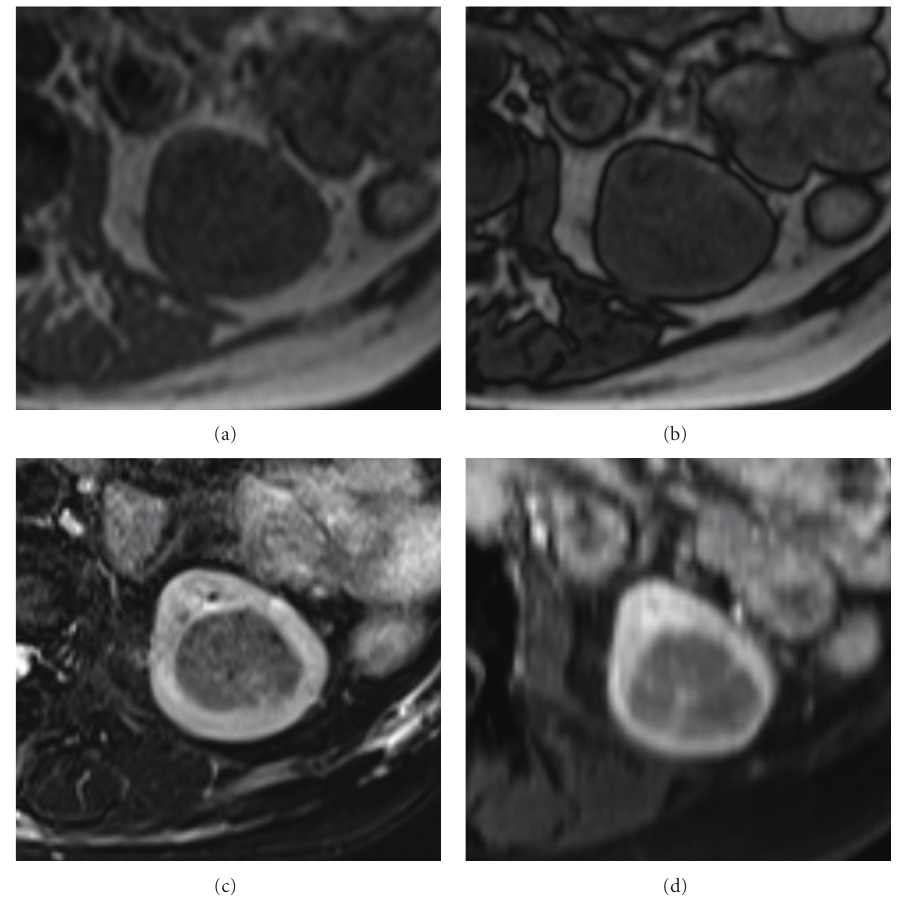
Figure 1: (a–d) Axial MR images of the left kidney, T1-weighted in-phase (a) T1-weighted opposed phase (b) T2-weighted fat-saturated (c), and T1-weighted, contrast-enhanced fat-saturated (d). The left renal mass is isointense in T1-weighted imaging without evidence of fatty components (a, b); the small hypointense spots in fat-saturated T2-weighted imaging are vessels (c). The mass is hypointense in T1-weighted imaging after i.v. contrast media (d); solley centrally there are KM-enhancing foci representing vessels (d).